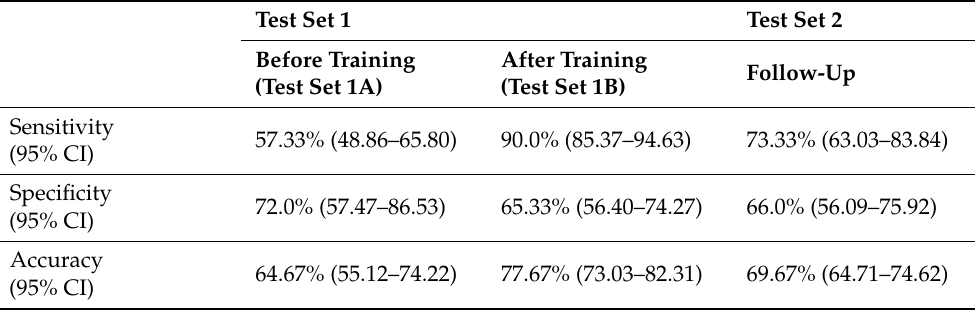
Table 1. Diagnostic test scores of the endoscopists at various testing